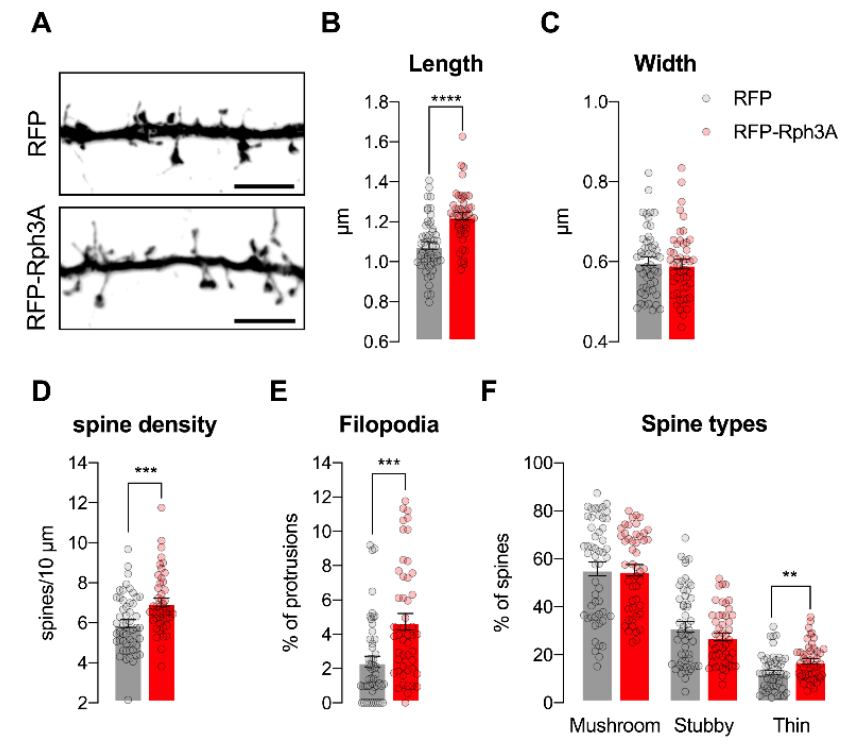
Figure 2. Rph3A overexpression promotes dendritic spine formation. ( A ): Confocal images of GFP filler in the dendritic spines of RFP ( up ) or RFP-Rph3A ( down ) transfected neurons. Scale bar: 5 µm. ( B – F ): Bar graph representation of mean ± SEM spine length ( B ), spine head width ( C ), spine density ( D ), filopodia proportions ( E ), and spine types percentage ( F ) in RFP (grey) or RFP-Rph3A (red) transfected neurons. Unpaired t -test (length, width, spine types), Mann–Whitney U test (spine density, filopodia). ** p < 0.01; *** p < 0.001; **** p < 0.0001. Dots represent single